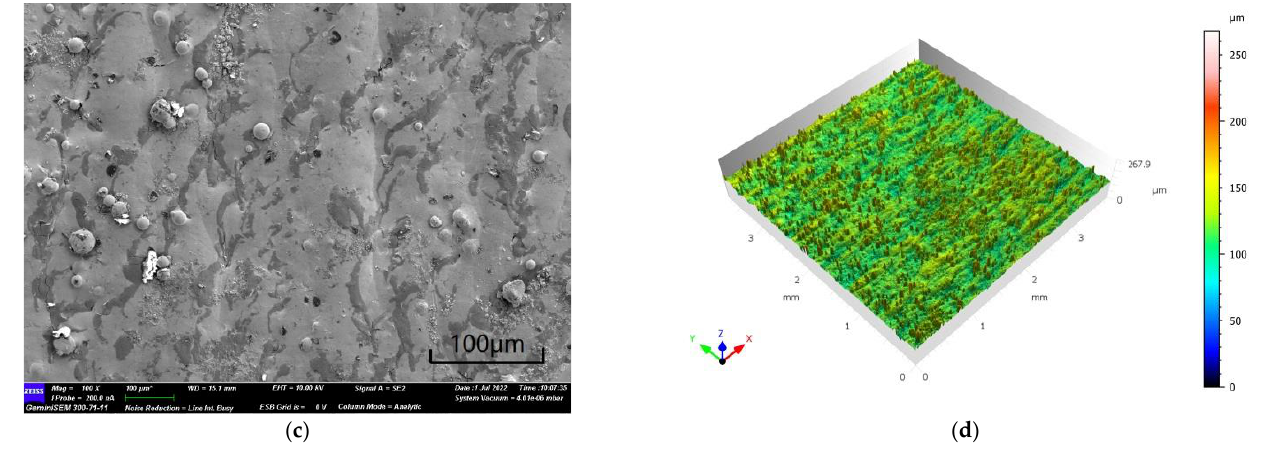
Figure 8. SEM images and 3D profiles of Part B ’ : ( a , b ) horizontal plane; ( c , d ) vertical surface.